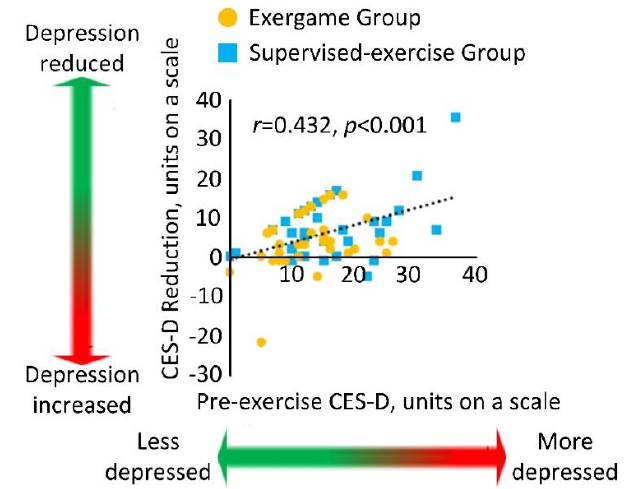
Figure 3. Correlation between the baseline CES-D score and the score reduction for the exergame and supervised exercise groups.